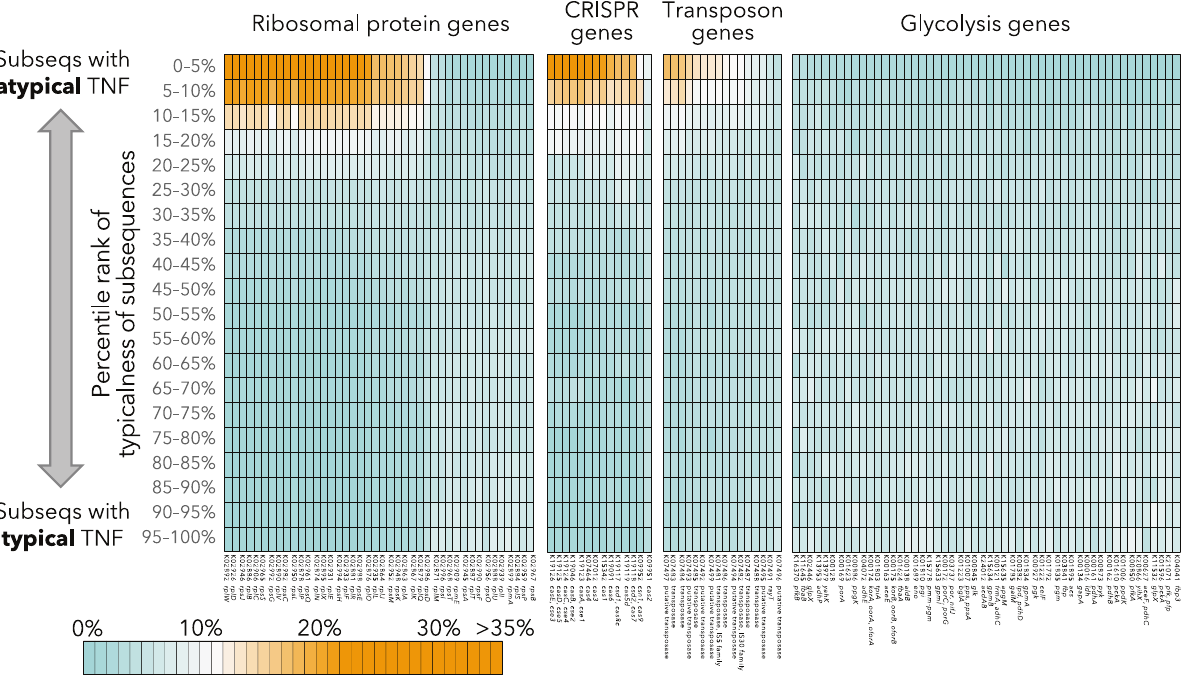
Fig. 4 Enrichment of orthologs in subsequences with typical and atypical tetranucleotide frequencies. Each column summarizes the distribution of each ortholog among subsequences. The colors (range from blue, white, to orange) indicate the proportion of gene copies found on subsequences with speci fi c typicalness ranks. For example, if cells in deep orange are aggregated in upper rows, that ortholog is enriched in subsequences with highly atypical tetranucleotide frequencies. TNF tetranucleotide